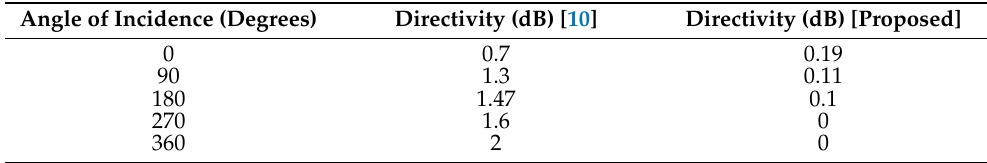
Figure 6. Variation of directivity with incident angles. Table 5. Incident